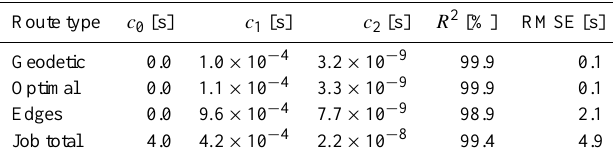
Table 9. VISIR model performance metrics. The coefficients are identified by least-square fits of Eq. (49). Routing jobs were run for grids of size N in the range strained for all but the case of the “job total” computing time. Com- puter features: 3.5GHz Intel Core i7 processor with 32GB RAM, 1600MHz